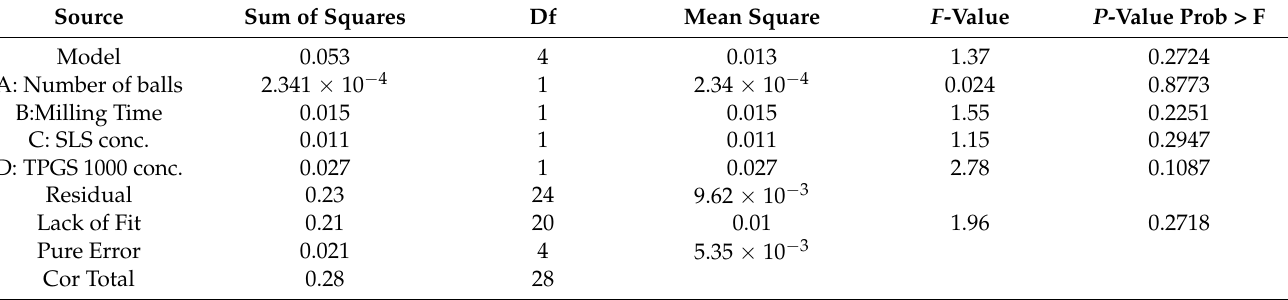
Table 5. ANOVA data for the response surface linear model for